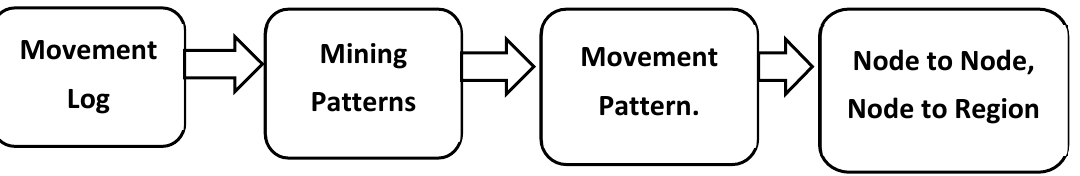
Figure 3. Steps of the pa tt ern recognition algorithm.